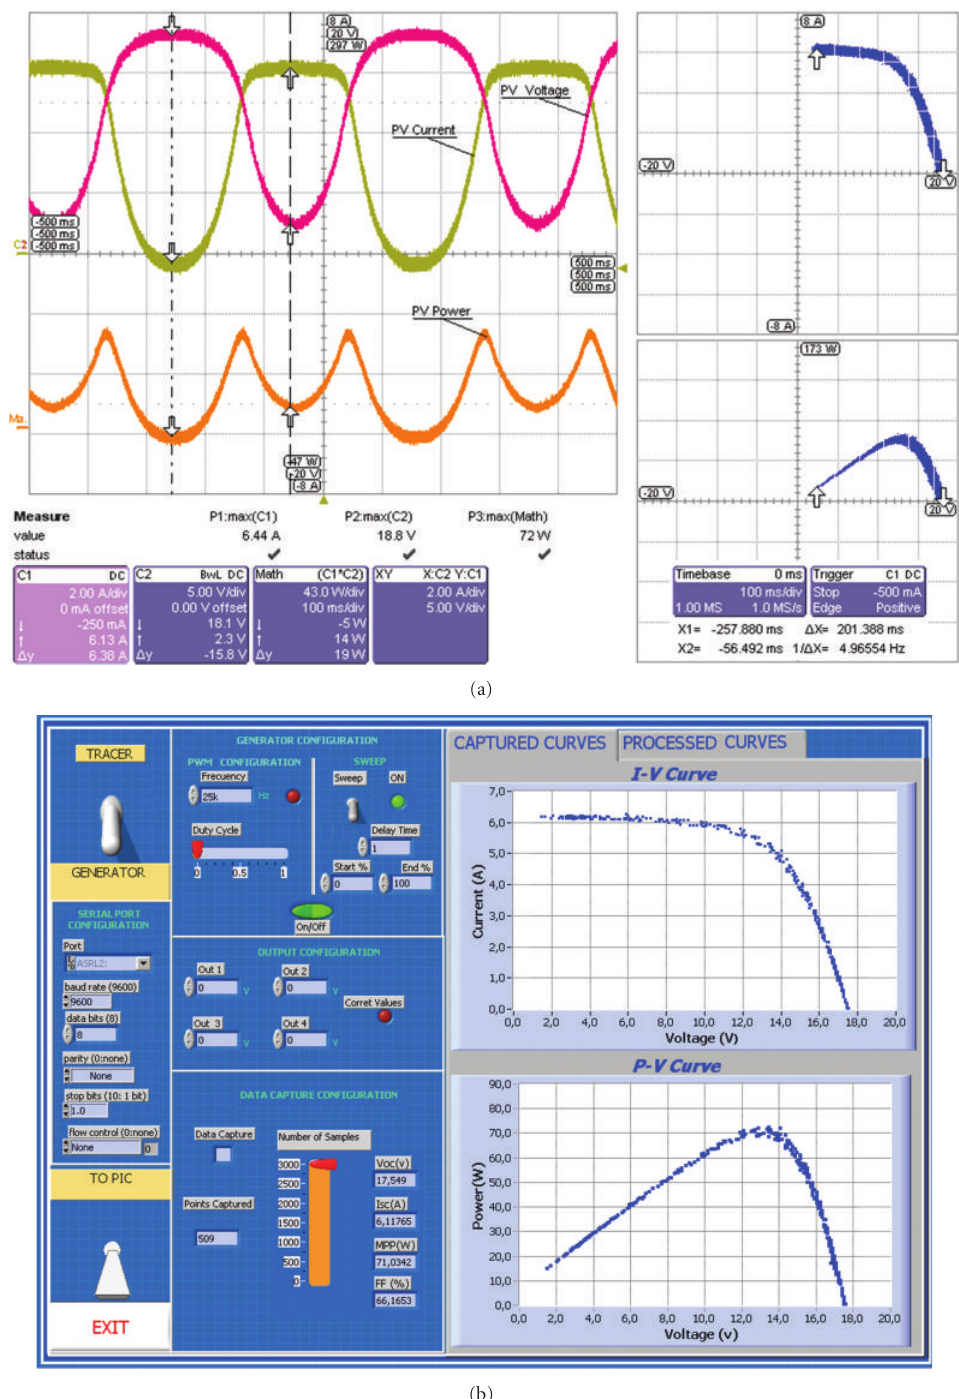
Figure 6: (a) Current (Channel C1: 2 A/div, 100 ms/div), voltage (Channel C2: 5 V/div, 100ms/div), and power (Math C1 ∗ C2: 43 W/div, 100ms/div) measurement. XY representation. (b) I-V and P-V curves obtained by means of the proposed system. DCS from 0 to